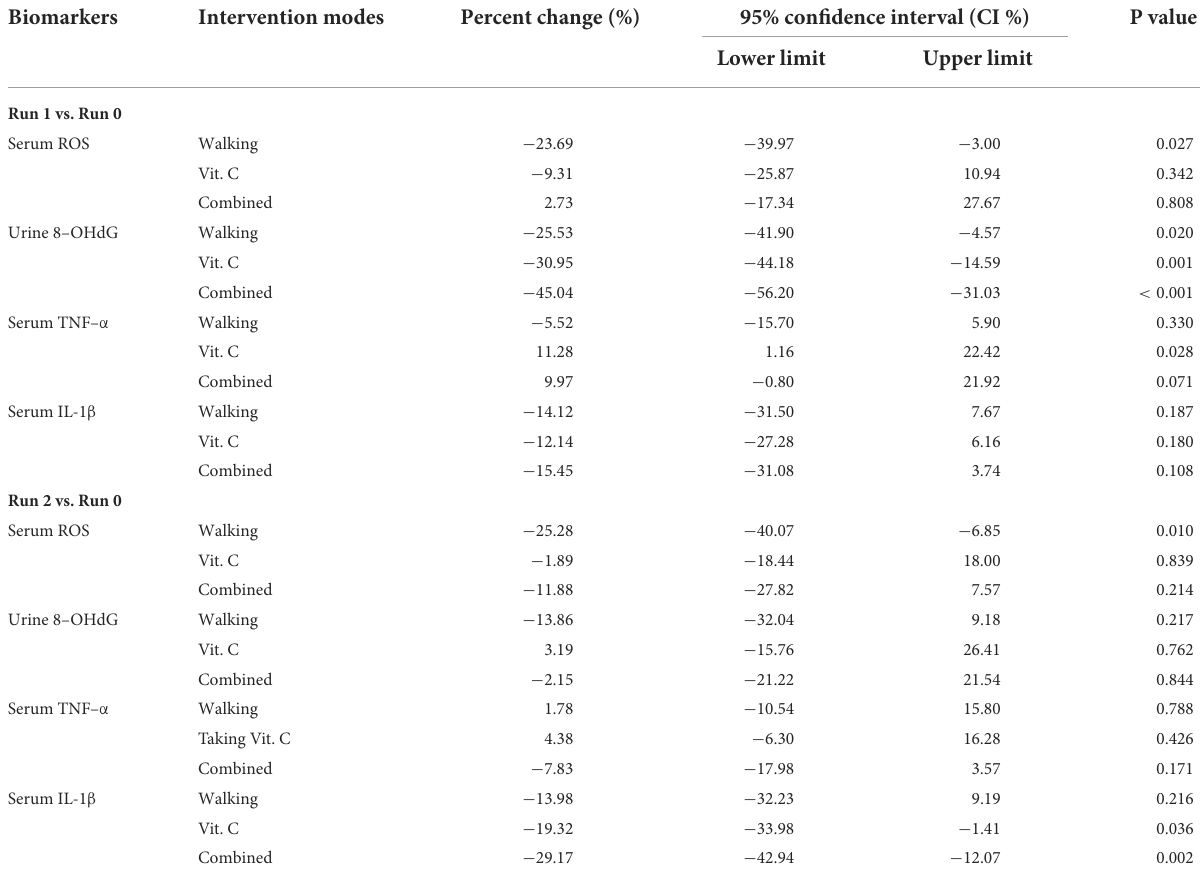
TABLE 3 Percentage change, 95% confidence interval, and p -value range for biomarkers during Run 1 and Run 2 compared to results from Run 0.